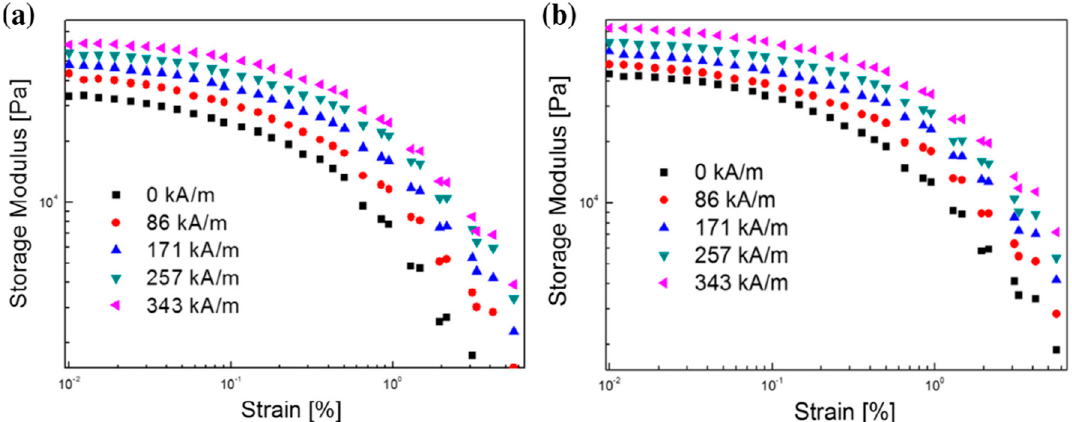
Figure 4. Strain amplitude sweep curves of the NR-based MR elastomers under various magnetic field strengths: ( a ) isotropic MR elastomers and ( b ) anisotropic MR elastomers (reprinted with permission from [50], Copyright 2016 Elsevier B. V., New York, NY, USA).